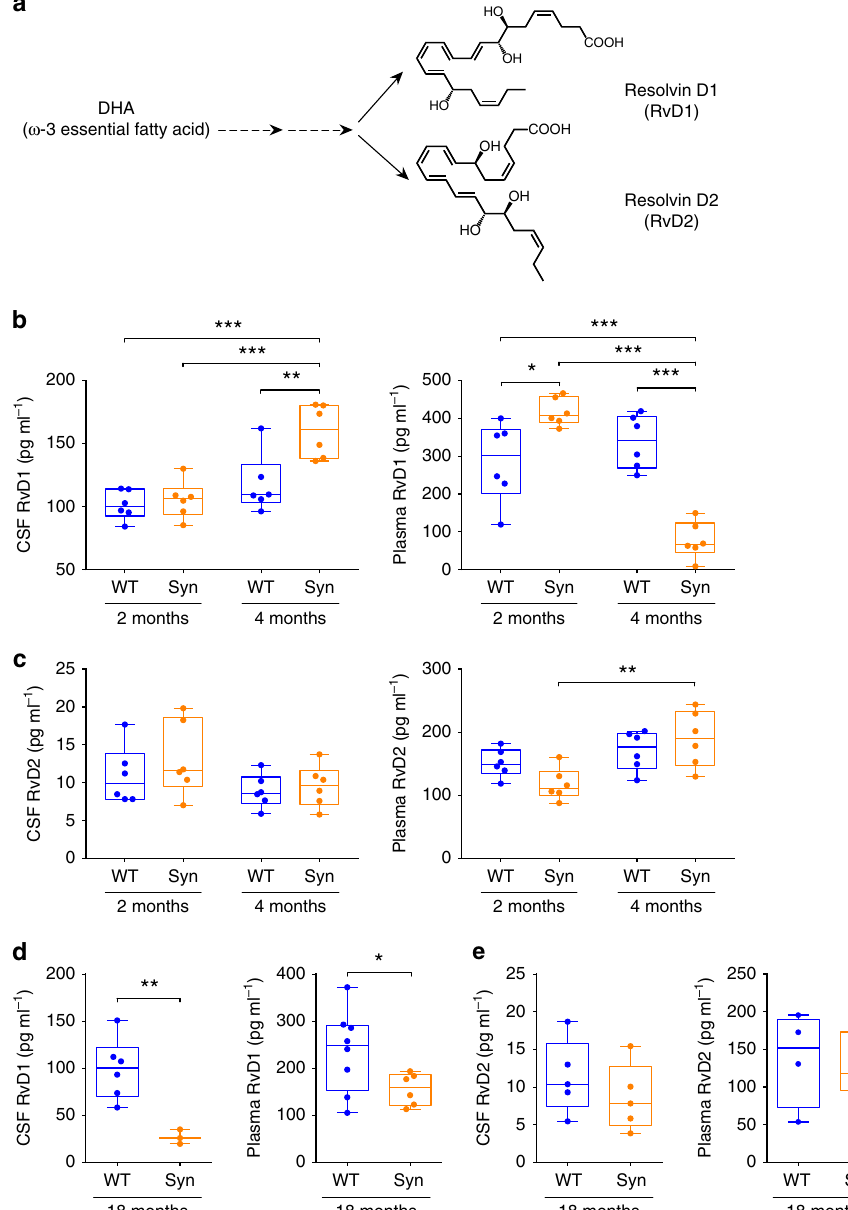
Fig. 6 Age-dependent changes in central and peripheral RvD1 levels in Syn rats. a Chemical structure of RvD1 and RvD2, derived from docosahexaenoic acid (DHA) metabolism. b Quanti fi cation with ELISA of RvD1 in the CSF (left) and plasma (right) of WT and Syn rats at 2 and 4 months of age (CSF: 6 WT, 6 Syn rats per age; two-way ANOVA: genotype × age, F 1,20 = 6.38, P = 0.020; genotype, F 1,20 = 9.61, P = 0.006; age, F 1,20 = 22.36, P = 1.00 × 10 − 4 ; WT 2 -Syn 4 *** P = 1.00 × 10 − 4 , Syn 2 -Syn 4 *** P = 3.00 × 10 − 4 , WT 4-Syn 4 ** P = 0.004 with Bonferroni ’ s; plasma: 6 WT, 6 Syn for each age;